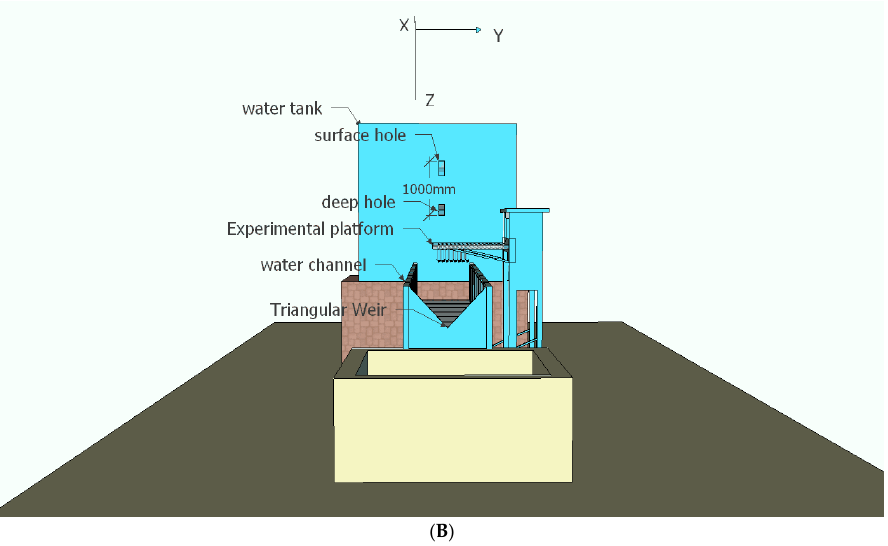
Figure 2. ( A ) Experiment layout: side view; ( B ) experiment layout: front view.